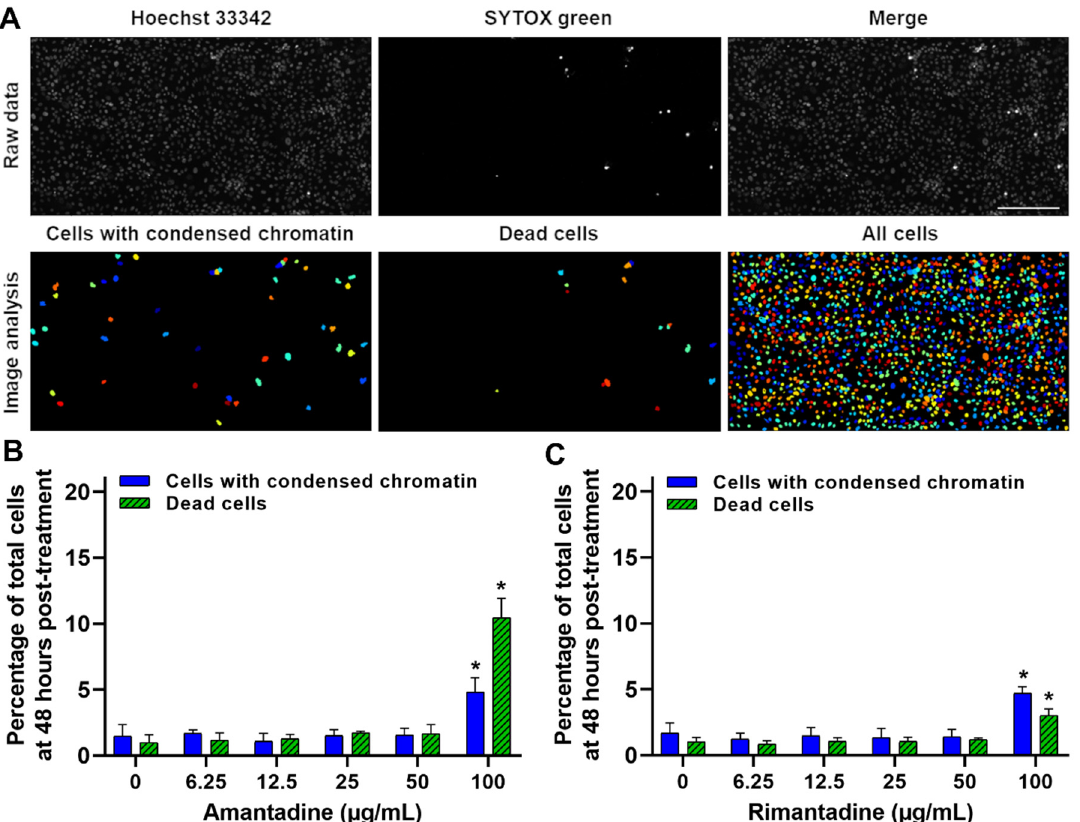
Figure 3. Amantadine and rimantadine hydrochlorides have no significant cytotoxic effect on Vero cells at concentrations with the shown antiviral activity against ZIKV. Vero cells monolayers were Hoechst 33342 stained, and at 48 h post-treatment with culture medium containing a combination of SYTOX green and different concentrations of amantadine or rimantadine hydrochlorides, cells were analyzed by live-cell imaging. ( A ) Image analysis of Hoechst 33342 and SYTOX green stained Vero cells at 48 h post-treatment with 50 µg/mL of amantadine hydrochloride, to quantify the number of cells with condensed chromatin and dead cells, respectively. A representative experiment is shown (n = three independent experiments, magnification of 200X, scale bar = 200 µm). ( B , C ) Percentage of total Vero cells with condensed chromatin and dead cells at 48 h post-treatment with different concentrations of amantadine or rimantadine hydrochlorides, respectively. CC 50 values were >100 µg/mL for both treatments. Data are expressed as mean ± SD of three independent experiments. * p < 0.001 calculated to cells with the same staining among different antiviral doses.